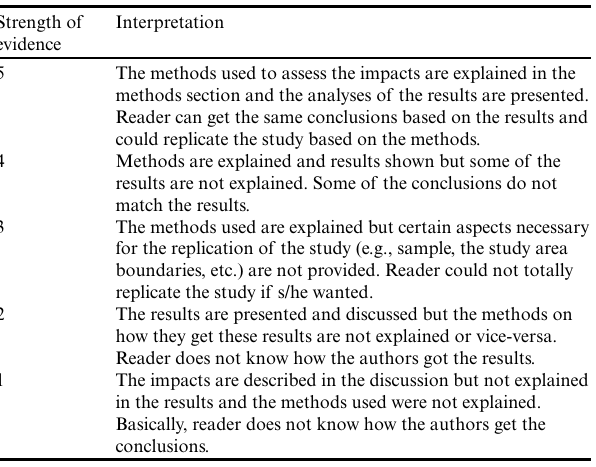
Table 2 . Explanatory variables, their definitions, and their sources of data extraction